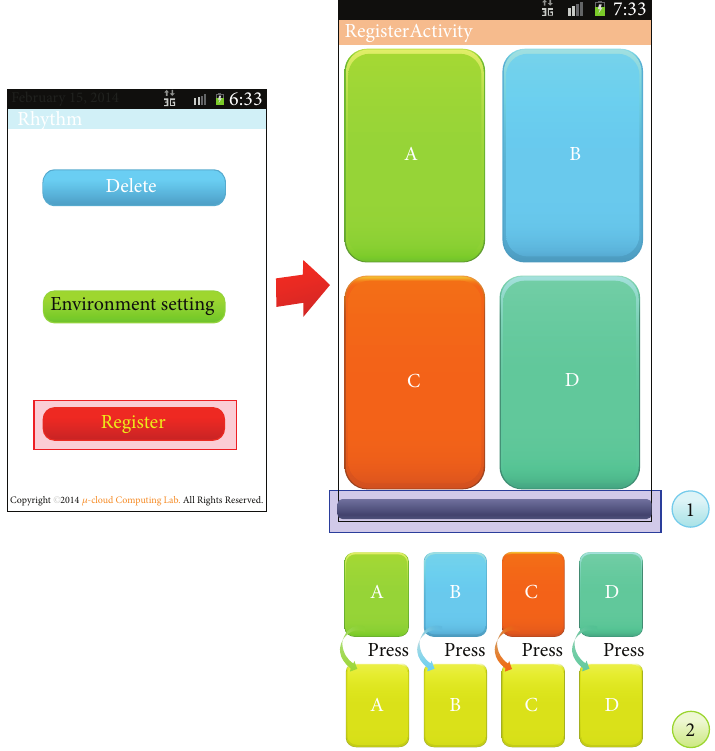
Figure 7: Register activity of the